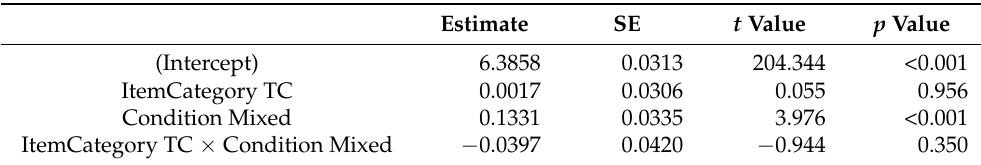
Table 3. Output of the LMER model for L1 tasks with item category (cognate or target language control word (TC)) and condition (pure or mixed language condition) as fixed effects.